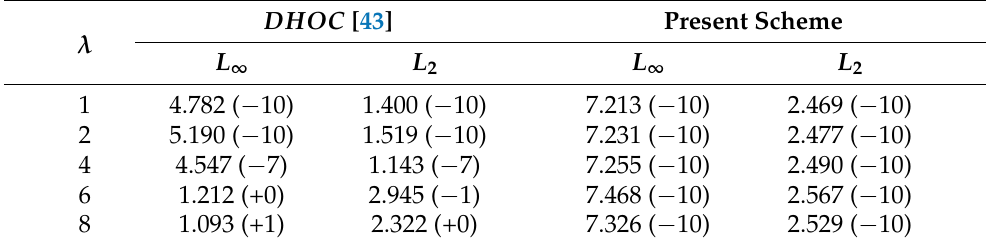
Table 11. The L ∞ error and L 2 error when h = 1 Problem